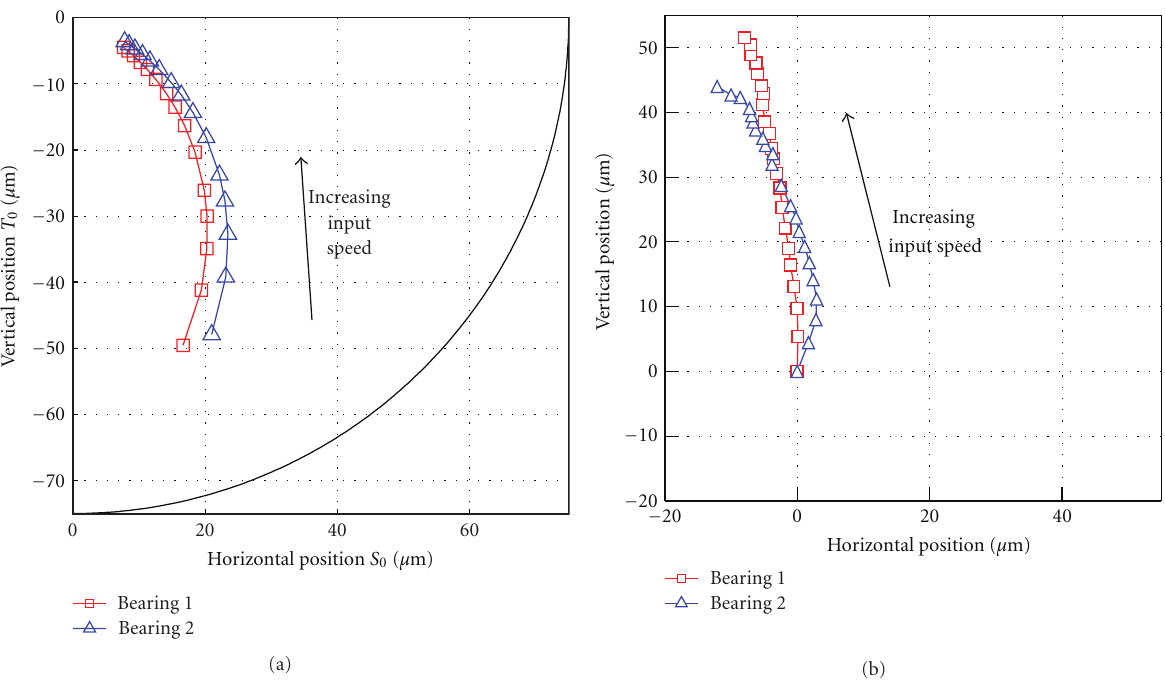
Figure 9: Comparisons of the simulated (a) and measured [16] (b) position of the shaft centre inside the bearings at static equilibrium (helical gear set) C r = 1540 N · m, 50 rad/s < Ω 1 < 700